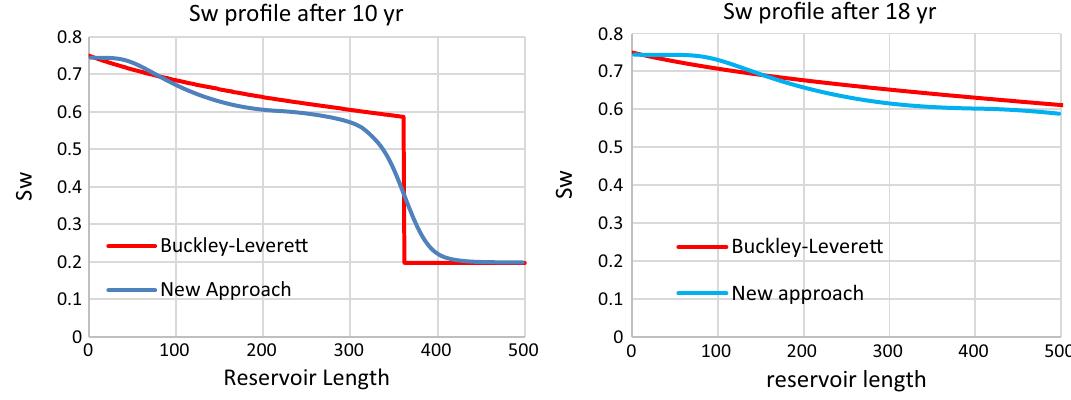
Fig. 14 a Comparison of Sw profile after 10 years for constant pressure boundary case. b Comparison of Sw profile after 18 years for constant pressure boundary